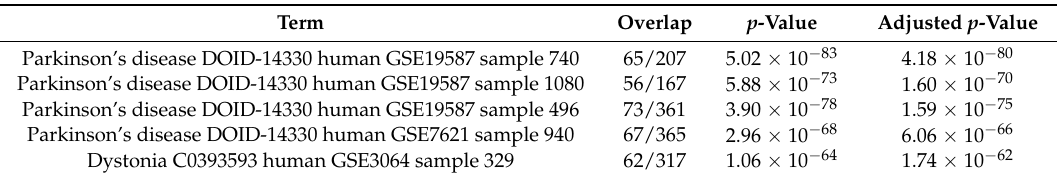
Table 2. Top ranked five categories in “Disease Perturbations from Gene Expression Omnibus (GEO) down” of Enrichr.